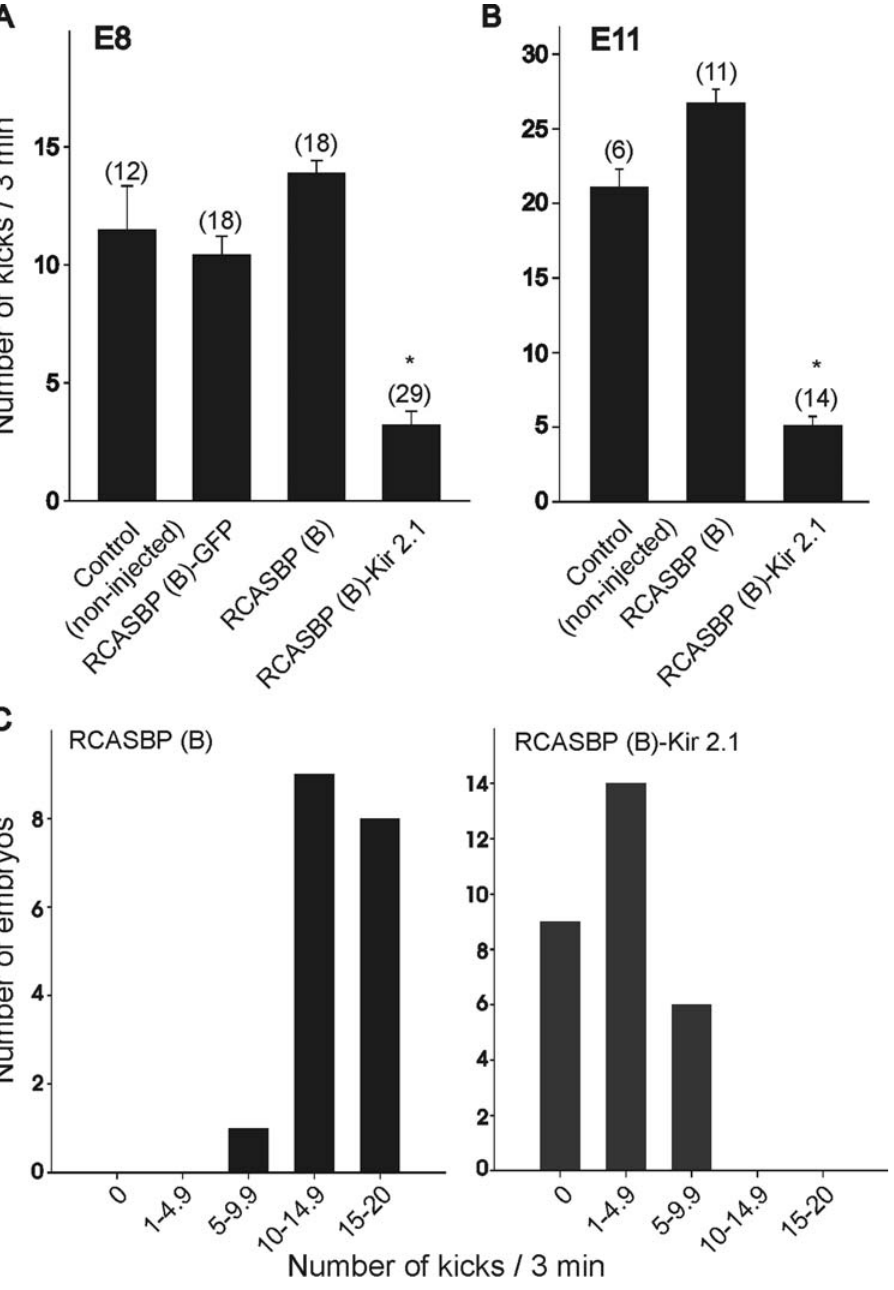
Figure 5. Effect of Kir2.1 expression on embryonic movement at E8 and E11 in chicken embryos infected with RCASBP(B), RCASBP(B)-GFP, or RCASBP(B)-Kir2.1. Controls consisted of non-injected embryos. A&B) Average number of kicks in a 3 min observation period in E8 ( A ) and E11 ( B ) chicken embryos injected with different RCASBP(B) constructs. The number of embryos analyzed under different condition is given above each bar. C) Plot showing the distribution of the number of kicks in RCASBP(B) and RCASBP(B)-Kir2.1 infected embryos at